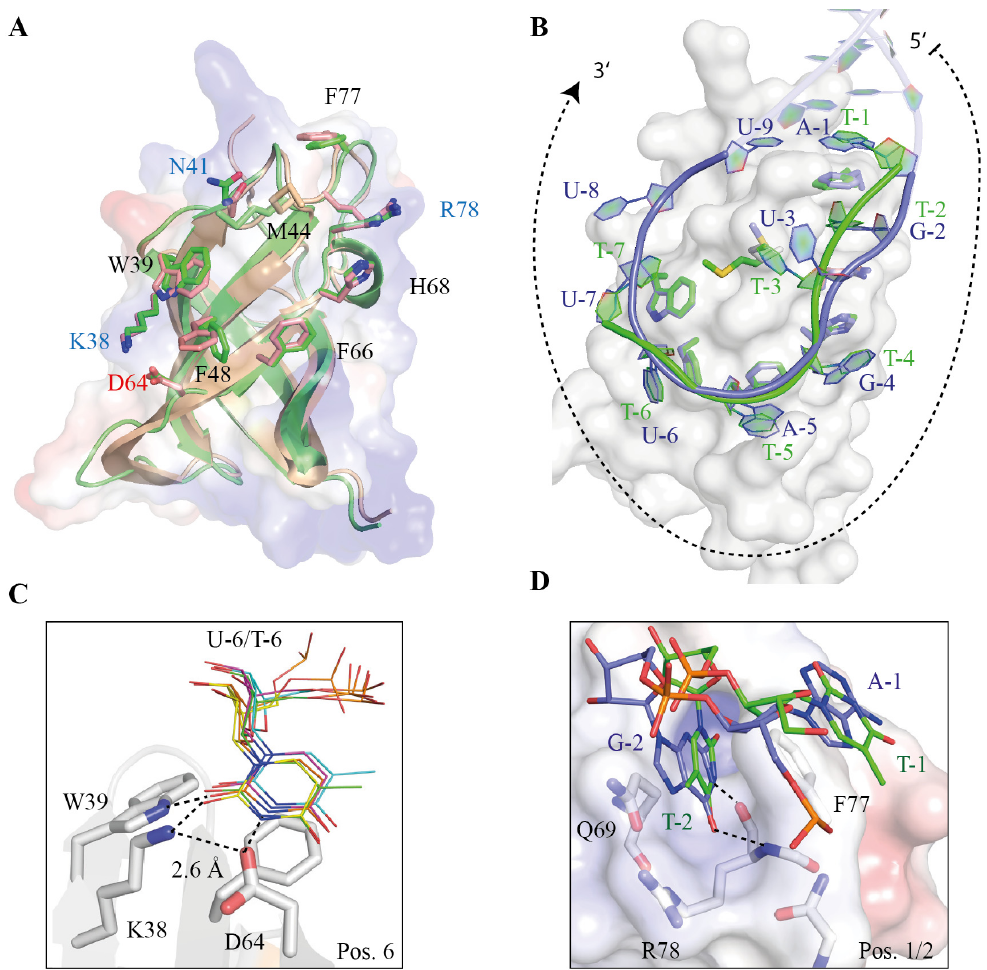
Figure 6. The Lin28 CSD can bind to a wide range of different RNA sequences. ( A ) Superimposition of unbound (skin color, PDB-ID 3ULJ) and heptathymidine-bound Xtr Lin28b CSD (green, PDB-ID 4A76). Both structures are highly conserved and reveal a pre-formed nucleic-acid binding platform with exposed aromatic residues; ( B ) Superimposition of Xtr Lin28b:dT (green) and mLin28s:preE- let-7f (RNA: blue, protein: gray, PDB-ID 7 3TS0). Both Lin28 CSDs bind single-stranded nucleic acids predominantly via base stacking interactions in a defined orientation. The protein nucleic-acid interaction surface is similar for binding subsites 1 to 7. Binding of an additional eighth (U-8) and ninth (U-9) base in mLin28:preE- let-7f is triggered by the formation of a closed RNA loop; ( C ) Superimposition of bound nucleotides at binding subsite 6 derived from various bacterial and Lin28 CSDs in complex with ssDNA/ssRNA (PDB-IDs 4A76, 4A75, 3TS0, 3TS2, 3PF4, 2HAX). All structures contained T or U nucleotides at this binding pocket. A highly conserved Lys-Asp salt bridge limits the size of the pocket and establishes specific hydrogen bonds with the T/U base; ( D ) Since few interactions are formed with the sugar-phosphate backbone, the bound oligonucleotides can adopt different backbone conformations to optimize binding with Lin28 CSD. For example, at binding subsite 2, the sugar-phosphate backbone of mLin28a:preE- let-7f is farther displaced from the protein, thereby enabling binding of G (G-2) instead of T (T-2) without disrupting hydrogen